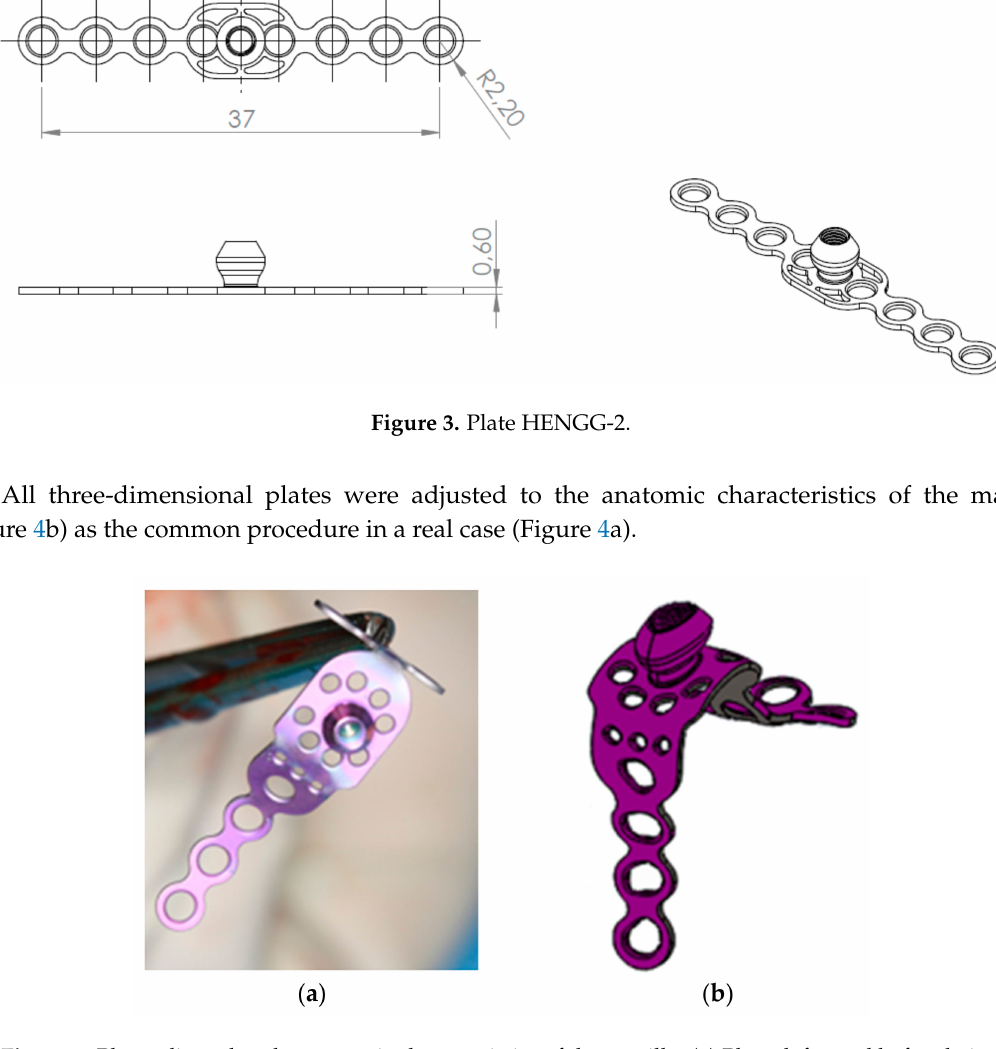
Figure 4. Plate adjusted to the anatomic characteristics of the maxilla: ( a ) Plate deformed before being placed in the patient; ( b ) three-dimensional model of a plate